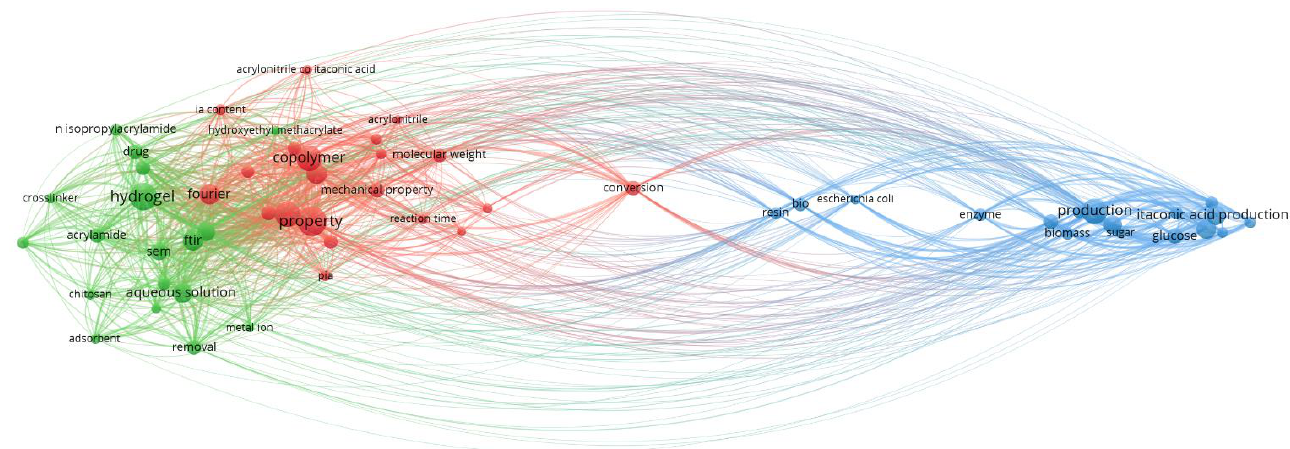
Figure 3. Biopolymer production with IA-related keywords, such as itaconic acid, hydrogel, biodegradable, biomass, copolymer, fermentation, polymerization, organic acid, and so on (VOSviewer version 1.6.17).